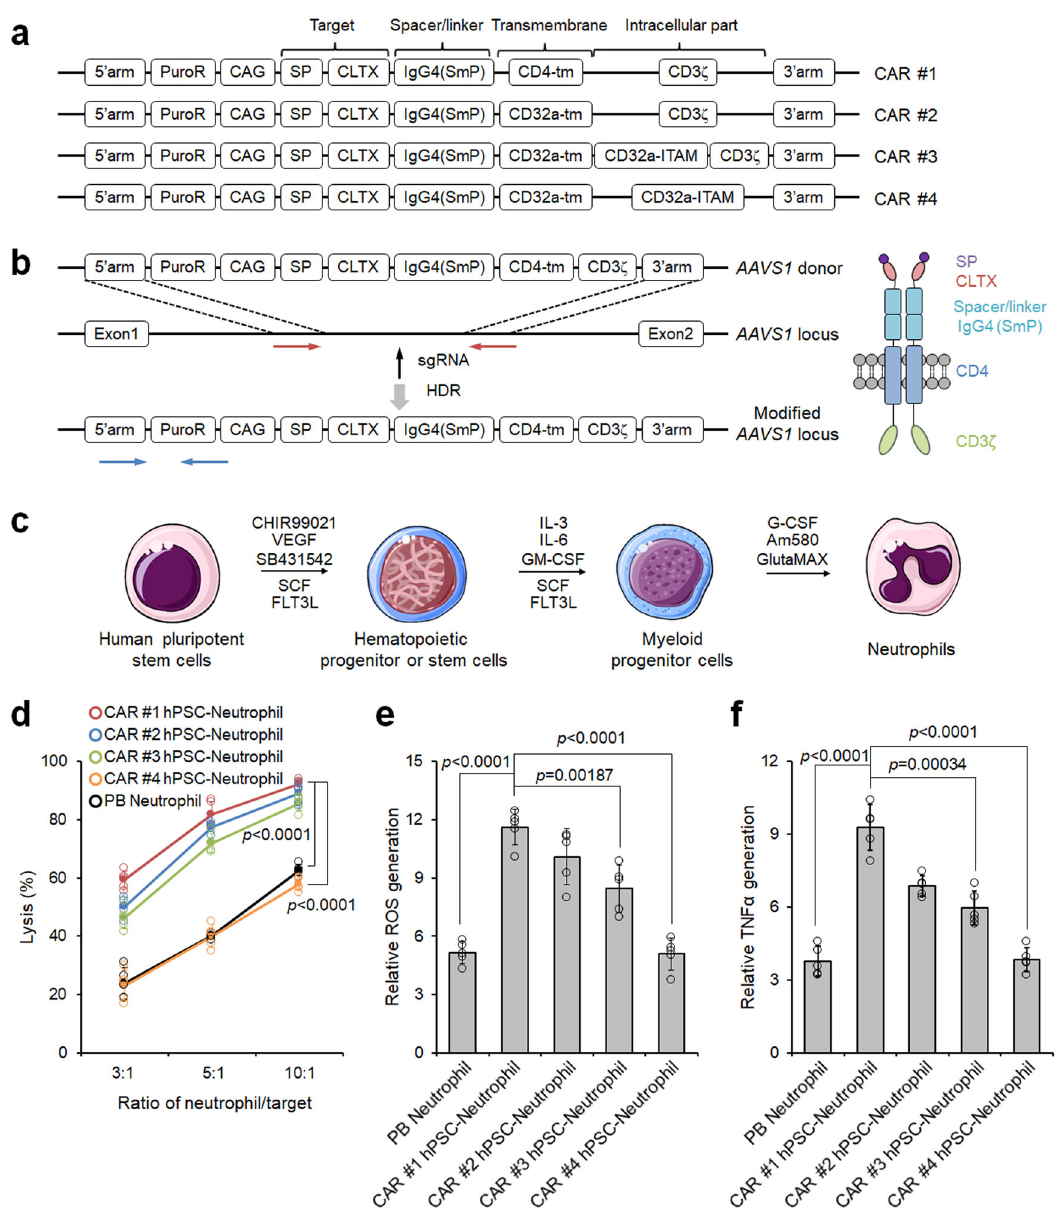
Fig. 2 | Screening neutrophil-speci fi c chimeric antigen receptor (CAR) struc- tureswithenhanced neutrophil-mediatedanti-tumoractivities.a Schematicof various CAR structures. b Schematic of CAR #1 construct and targeted knock-in strategy at the AAVS1 safe harbor locus of human pluripotent stem cells (hPSCs). Verticalarrowindicatesthe AAVS1 targetingsgRNA.Redandbluehorizontalarrows indicate primers for assaying targeting ef fi ciency and homozygosity,